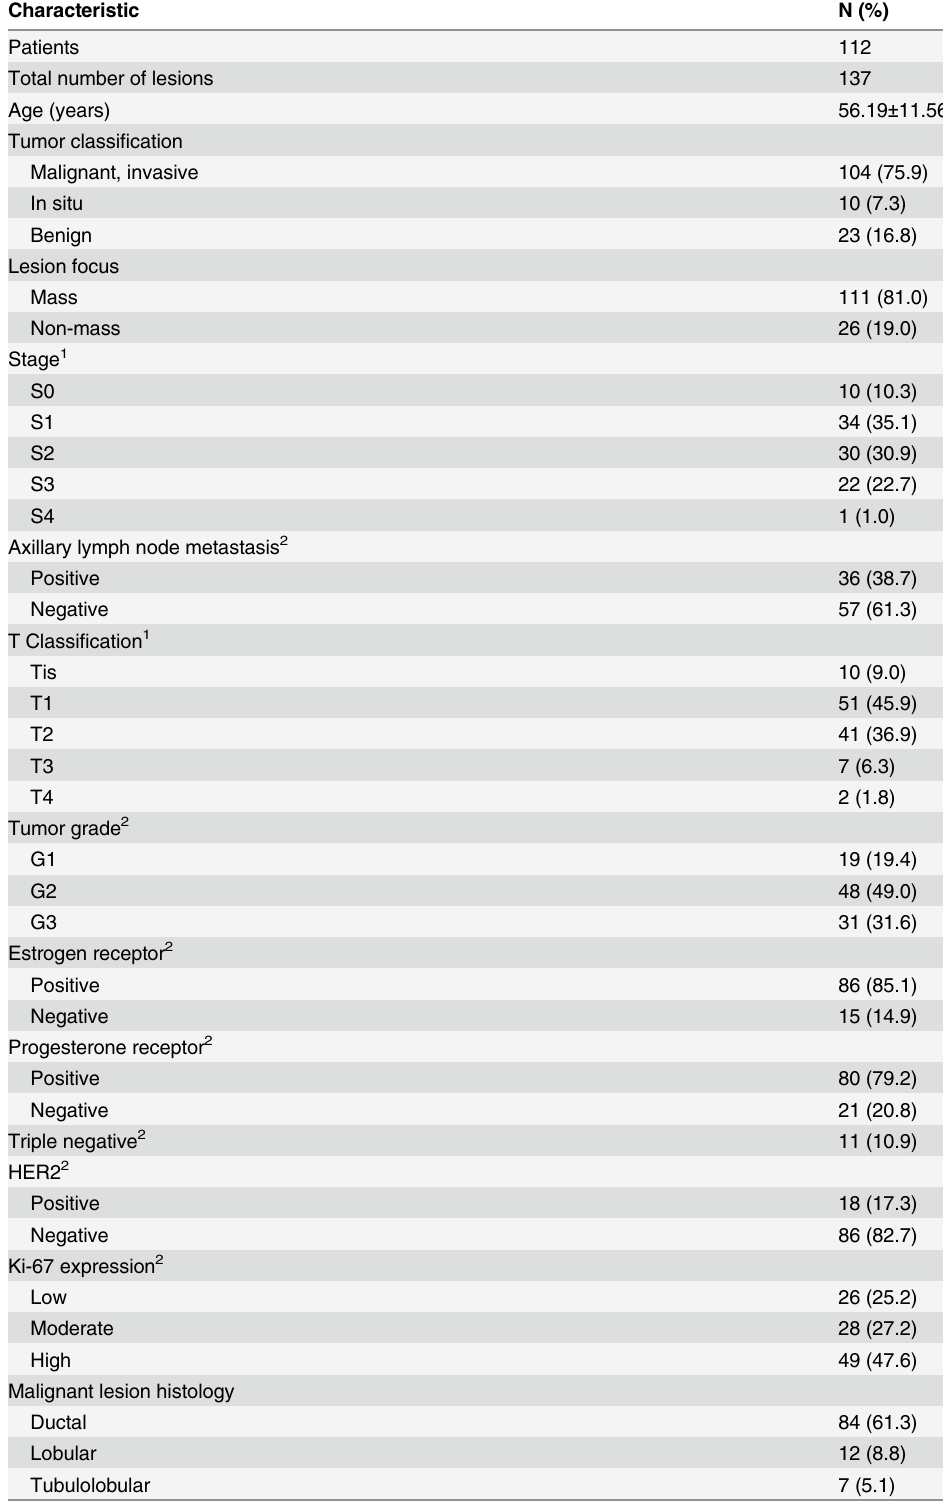
Table 1. Patient demographics and tumor